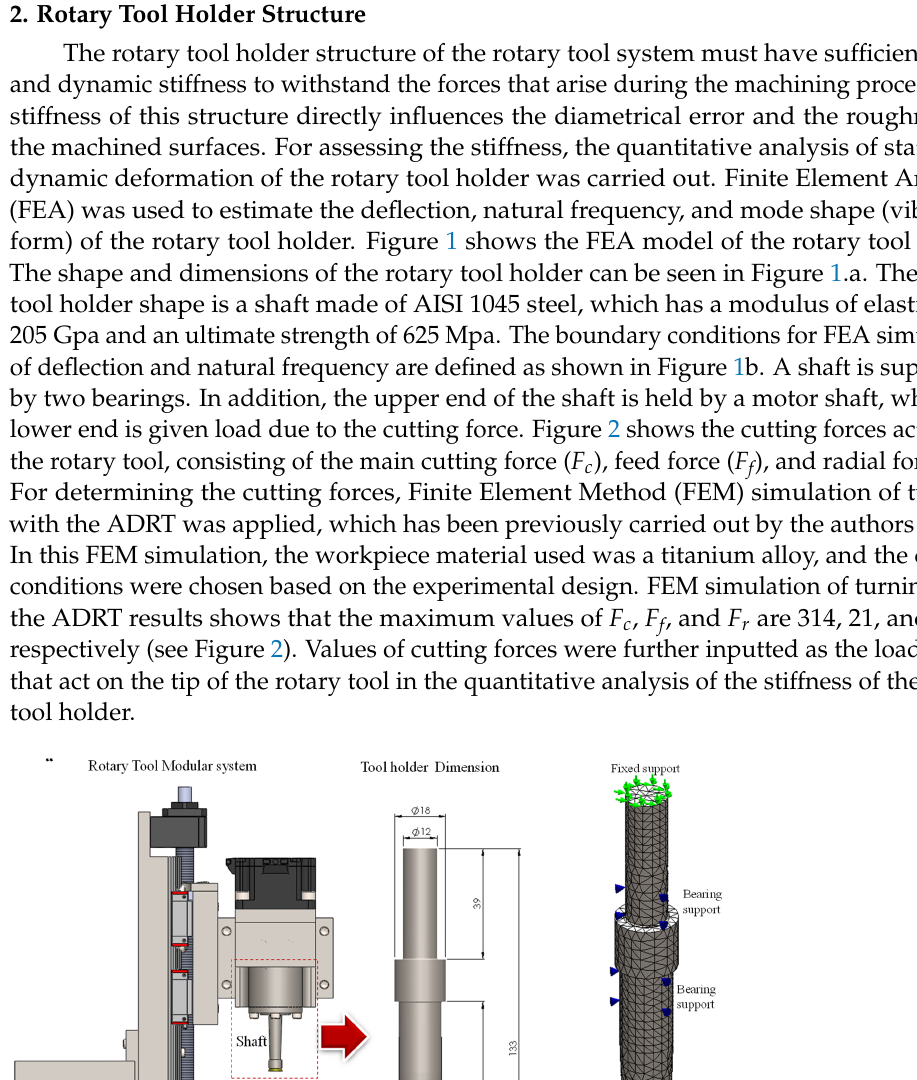
( b ) Figure 2. ( a ) FEM simulation of turning with the ADRT and ( b ) maximum cutting forces obtained (cutting conditions: cutting speed ( V w ) 60 m/min, feed ( f ) 0.2 mm/rev, depth of cut ( a p ) 0.2 mm, tool revolution speed ( n t ) 2000 rpm, inclination angle ( β ) 0°, tool diameter ( d t ) 16 mm). The results show that the maximum deflection of the rotary tool holder is 0.0109 mm (see Figure 3a), which is much smaller than the depth of cut used in this study, which is 0.2 mm. Furthermore, the minimum natural frequency of the mode shape of a rotary tool holder is 2050 Hz (see Figure 3b). To prevent the rotary tool holder from vibrating during the machining process, its natural frequency should not be equal to or close to the vibra- tion frequency of the rotating parts of the machine tool. It has been known that the fre- quency of the tool rotation ( f e , Hz) has a relation to the speed of the machine tool spindle ( n , rpm) during the machining process, which can be calculated with the following equa- tion [29]: